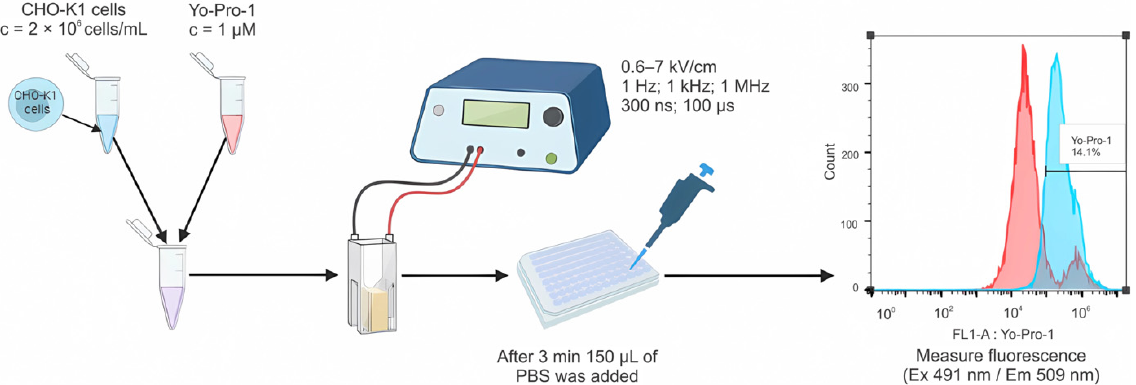
Figure 1. A scheme of cell membrane permeabilization experiments including gating strategy and permeabilized cells analysis. Blue color spectra indicate a shift in flureoscence intensity (Yo-Pro-1 positive cells); red—non-electroporated cells.